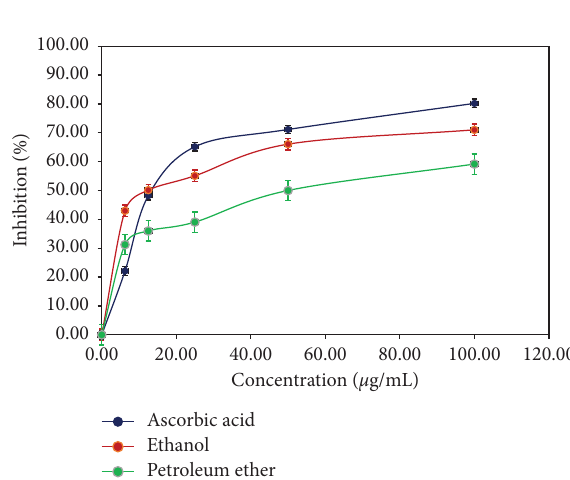
Figure 2: DPPH free radical scavenging activity of the extracts of C. nioroense and ascorbic